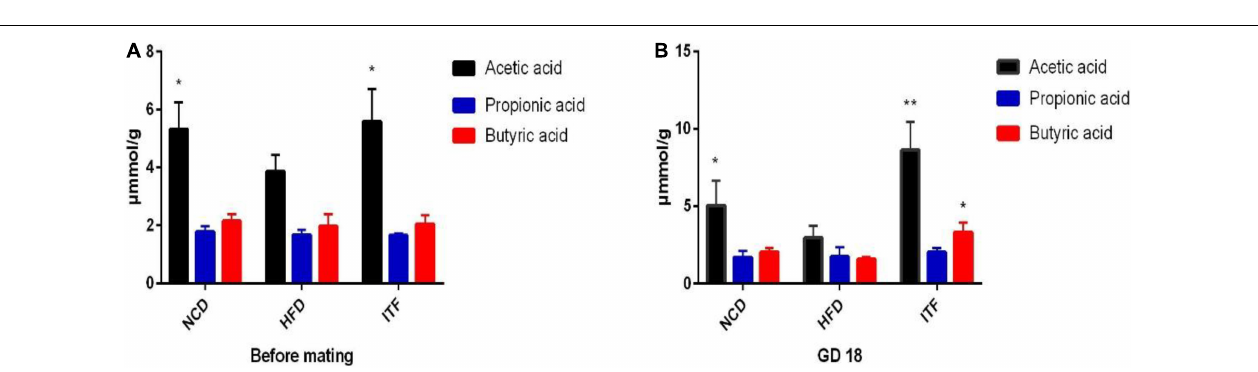
FIGURE 8 | Identification of the most differentially abundant among HFDG, ITFG, and NCDG analyzed by the LEfSe method. (A) LDA scores of differentially abundant taxa. (B) Relative abundance of Ruminococcaceae. (C) Relative abundance of Bacteroidaceae.